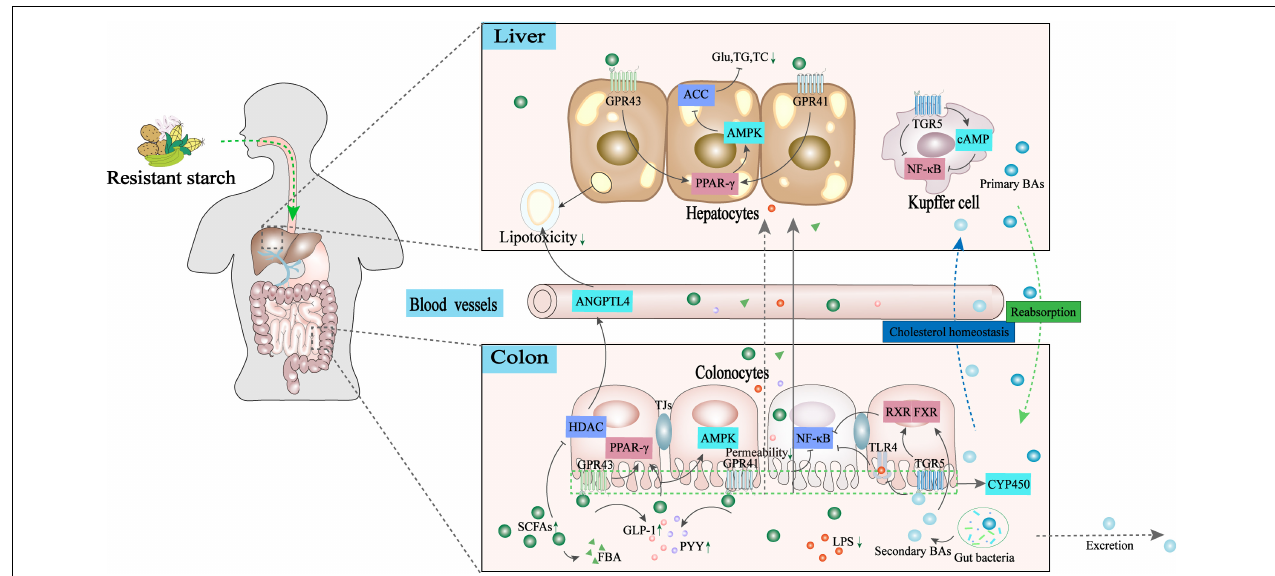
FIGURE 3 | Potential mechanisms underlying RSs regulating the GLA immune-metabolic homeostasis toward NAFLD mitigation. The gut bacterial metabolites released after intake of RSs act as crucial molecules that interact with a broad range of sensing receptors along with the GLA. (1). Secondary BAs bind to TGR5/FXR receptors in the intestine, inhibiting the TLR4/NF- κ B inflammatory signaling pathway to ameliorate NAFLD. (2). SCFAs binding with GPR41/GPR43 receptors in the intestine and hepatic activates PPAR- γ /AMPK signaling pathway to inhibit acetyl CoA carboxylase. As such, the production of glucose triglyceride and total cholesterol production is inhibited. (3). SCFAs can enhance the release of pro-peptide YY (PYY)/glucagon-like peptide 1 (GLP-1) by ligand binding with GPR43, which contributes to regulating appetite to maintain energy homeostasis. (4). SCFAs act as a histone deacetylase inhibitor to strengthen intestinal barrier functions, or elevate angiopoietin-like 4 secretions to reduce lipotoxicity and inflammation by potentially activating PPAR- γ . ACC, acetyl-CoA carboxylase; AMPK, adenosine 5 (cid:48) -monophosphate (AMP)-activated protein kinase; ANGPTL4, recombinant human angiopoietin-like protein 4; BAs, bile acids; CAT, catalase; FBA, N-(1-carbamoyl-2-phenyl-ethyl) butyramide; FXR, farnesoid X receptor; GPCR, G protein-coupled receptors; GLP-1, glucagon-like peptide 1; GPR43, G protein-coupled receptor 43; HDAC, histone deacetylase; NF- κ B, nuclear factor kappa-B; PGC1 α , peroxisome proliferator-activated receptor- γ coactivator-1 α ; PPAR- γ , peroxisome proliferator activated receptor- γ ; SCFAs, short-chain fatty acids; SOD, superoxide dismutase; TC, total cholesterol; TG, triglyceride; TLR4, toll-like receptor 4; PYY, pro-peptide